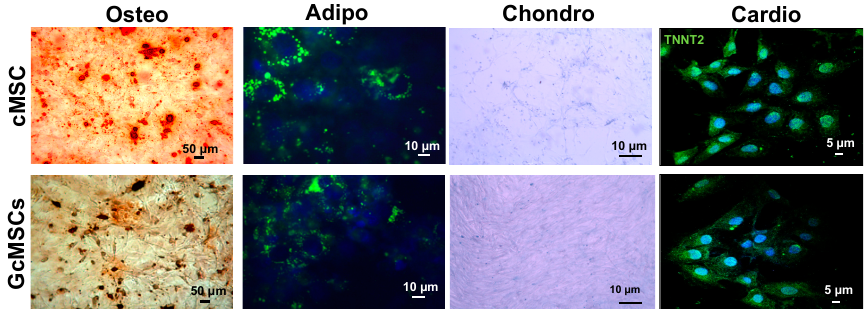
Figure 8. Multipotency of cMSC and GcMSCs. Chondrogenic, adipogenic and osteogenic differentiation of cMSC and GcMSC (cMSC pretreated with 136 μ g/mL of GSGa for one month). The cells were stained using Alizarin red S, AdipoRed and Alcian blue dyes for osteogenic, adipogenic and chondrogenic differentiation, respectively. For cardiogenic differentiation, cells were stained using an anti-TNNT2 and an Alexa Fluor ®® 488 donkey anti-mouse secondary antibody. Scale bars are 5, 10, 50 µ m as indicated. Experiments were performed as three biological